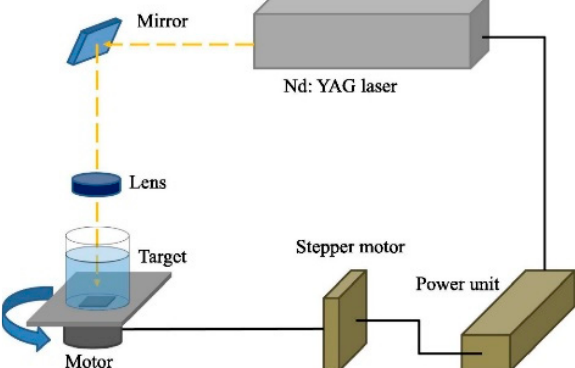
Figure 4. Pulsed laser ablation in liquid in flow mode [2].